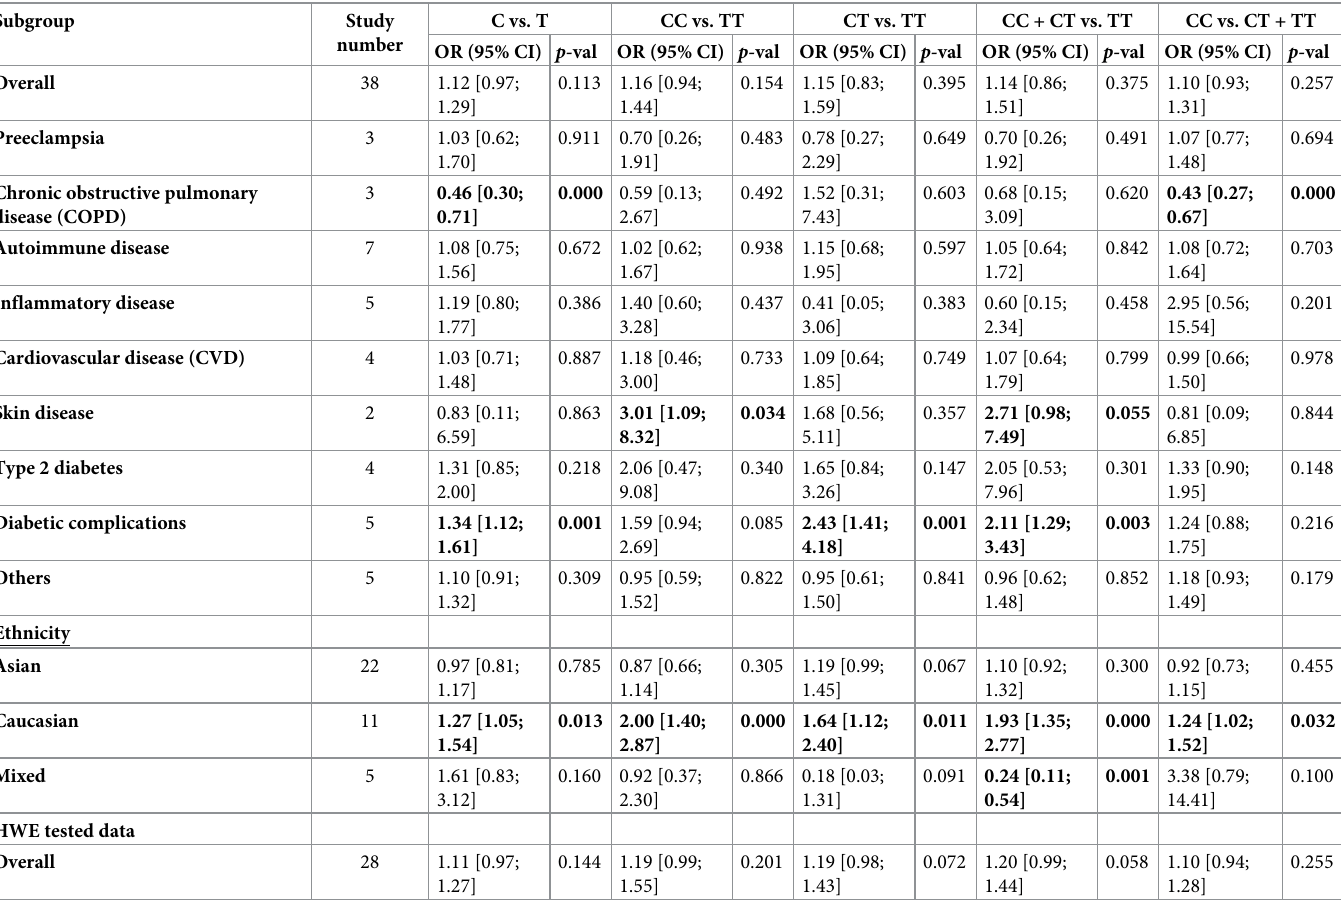
Table 2. Meta-analysis of the HIF1A rs11549465 C/T and T/C polymorphisms in association with different